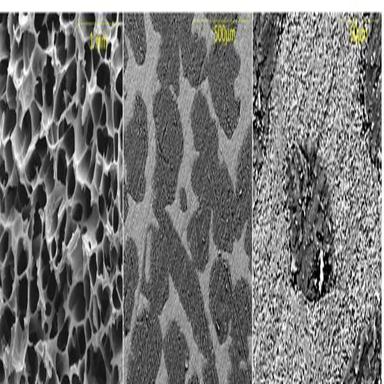
SEM images showing the pore structures of the porous ceramic preform before and after the infiltration with PC. A temperature of 250◦C and a load of 400 N were used. Initial solid ceramic loading 20 vol.%. Magnification × 50, × 120, × 780.